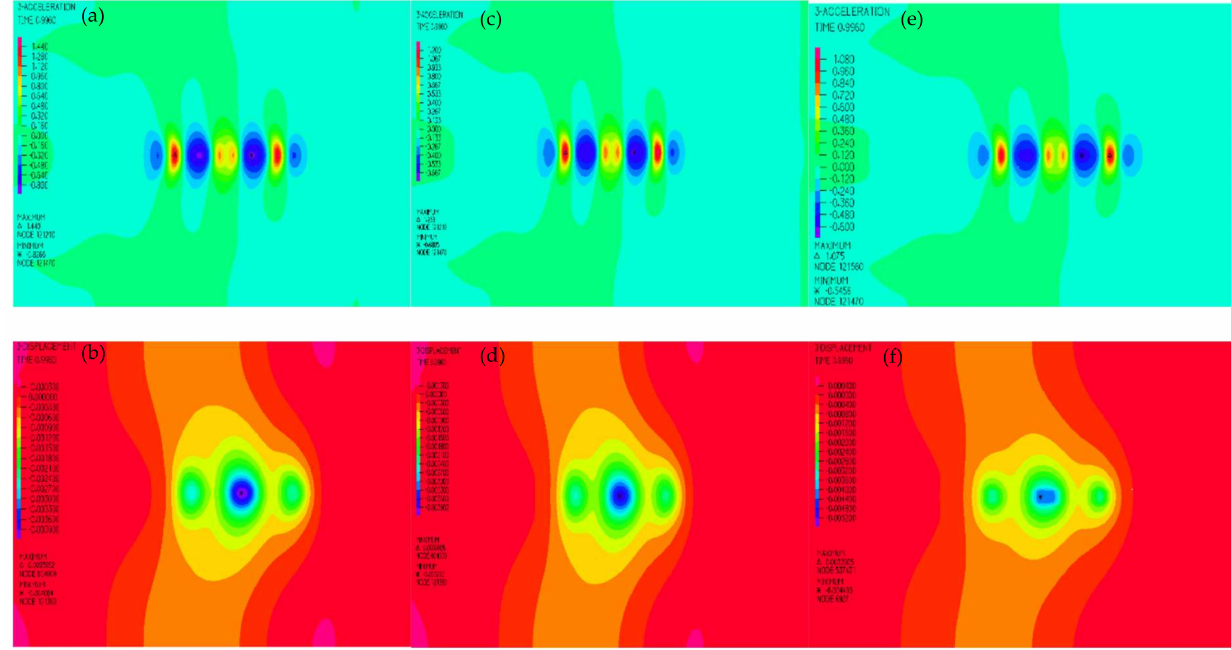
Figure 14. Comparisons of a z and d z cloud with different embankment stiffnesses: ( a ) a z , E 1 , v = 83 m/s; ( b ) d z , E 1 , v = 83 m/s; ( c ) a z , E 2 , v = 83 m/s; ( d ) d z , E 2 , v = 83 m/s; ( e ) a z , E 3 , v = 83 m/s; ( f ) d z , E 3 , v = 83